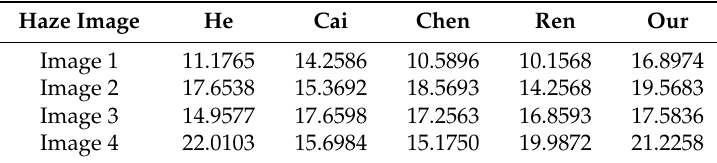
Table 3. The PSNR from images shown in Figure 13.